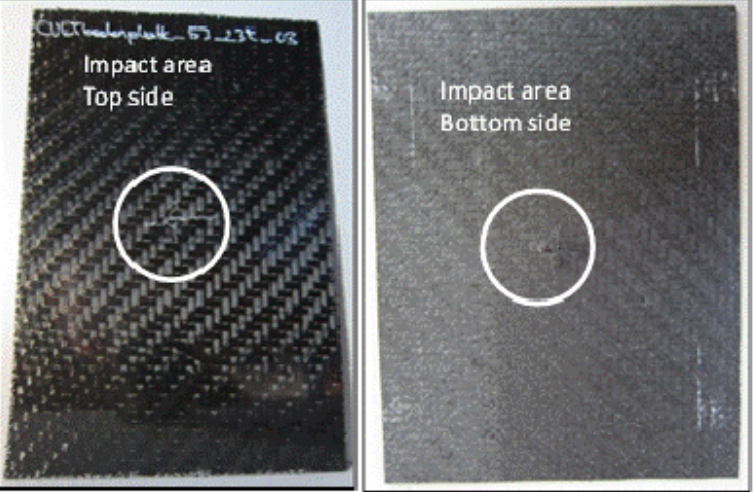
Figure 8. Visual failure detection for an impact energy of 5 J; ( left ) top side up; and ( right ) bottom side up.